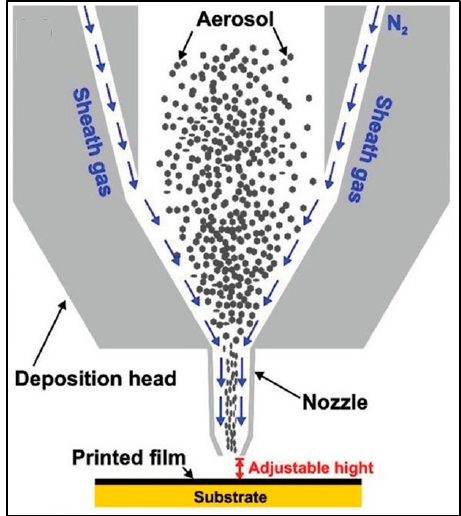
Figure 10. Schematic illustration of aerosol printing. Reproduced with permission from [97]. Copyright Wiley Online Library, 2019.